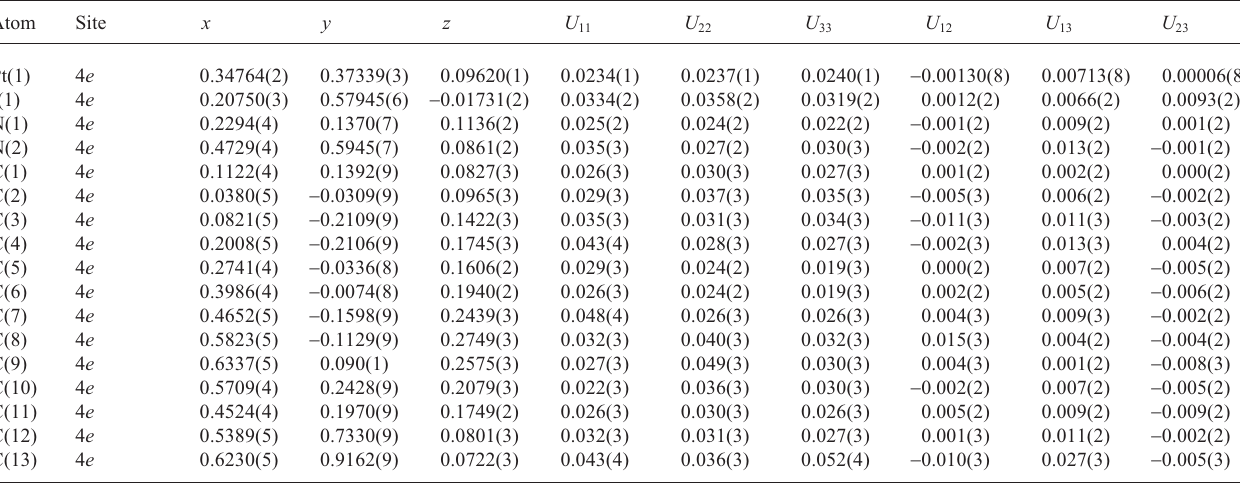
Table 3. Atomic coordinates and displacement parameters (in Å 2 )